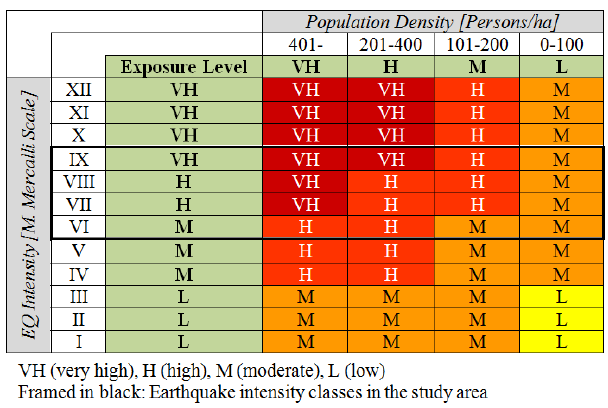
Fig. 3. Nighttime population density with seismic zones as back- ground information (base layer from Google Earth).